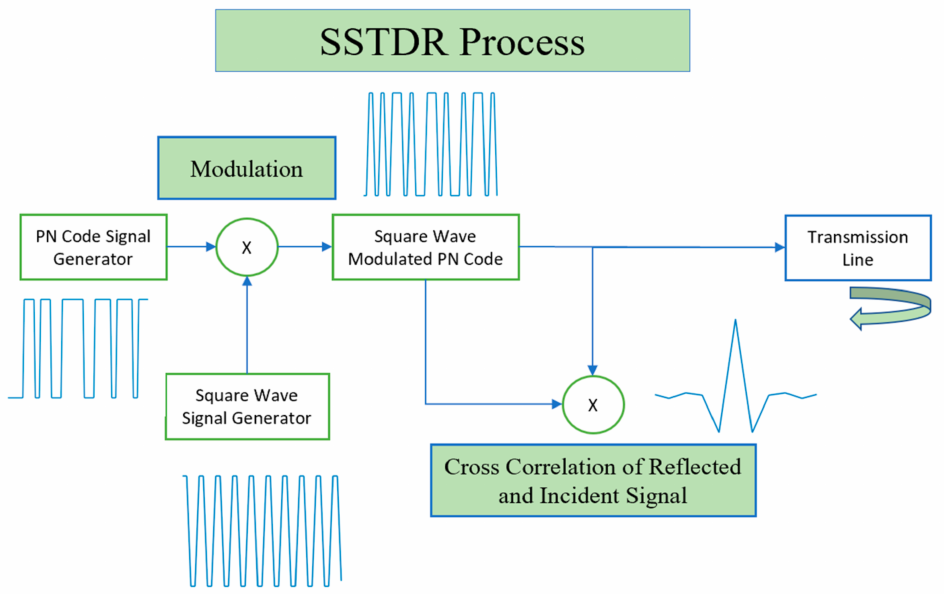
Figure 1. SSTDR process for incident signal, reflection, and cross correlation.